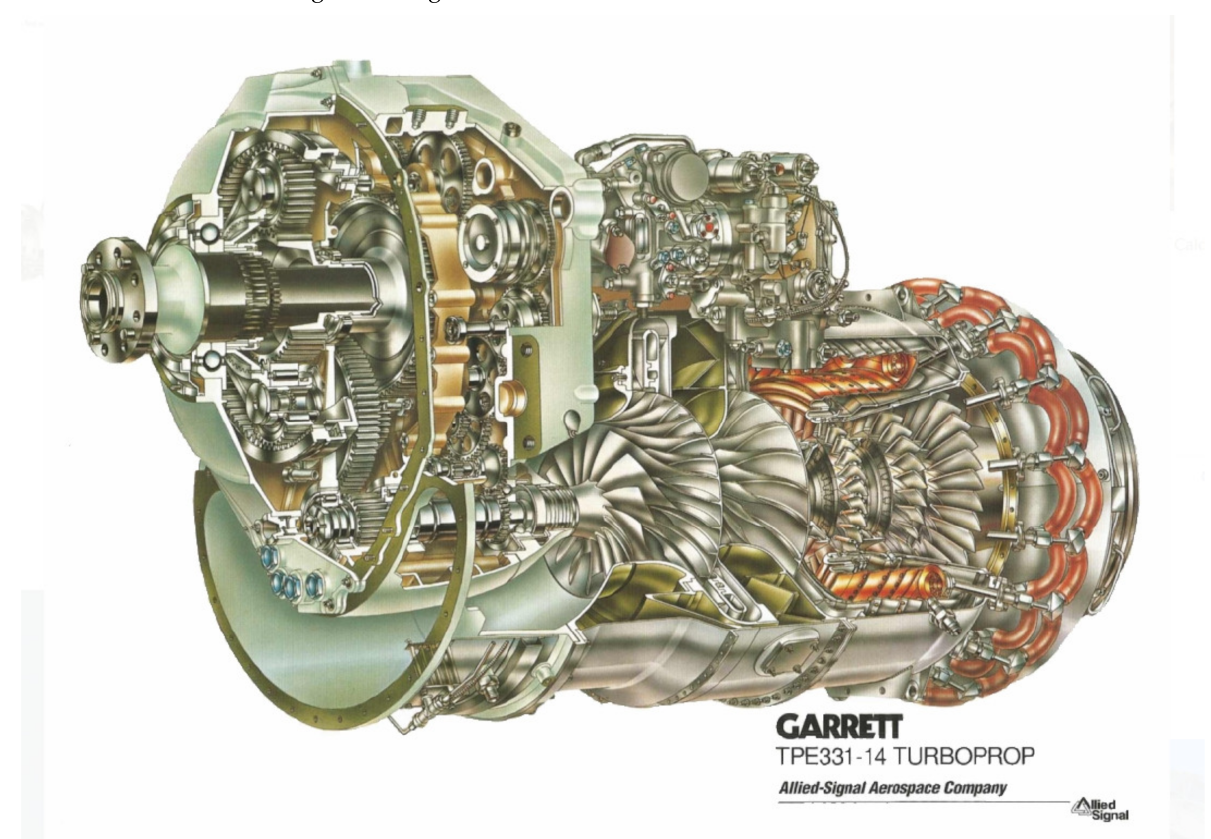
Figure 3. Garrett TPE331 turboprop engine cutaway drawing